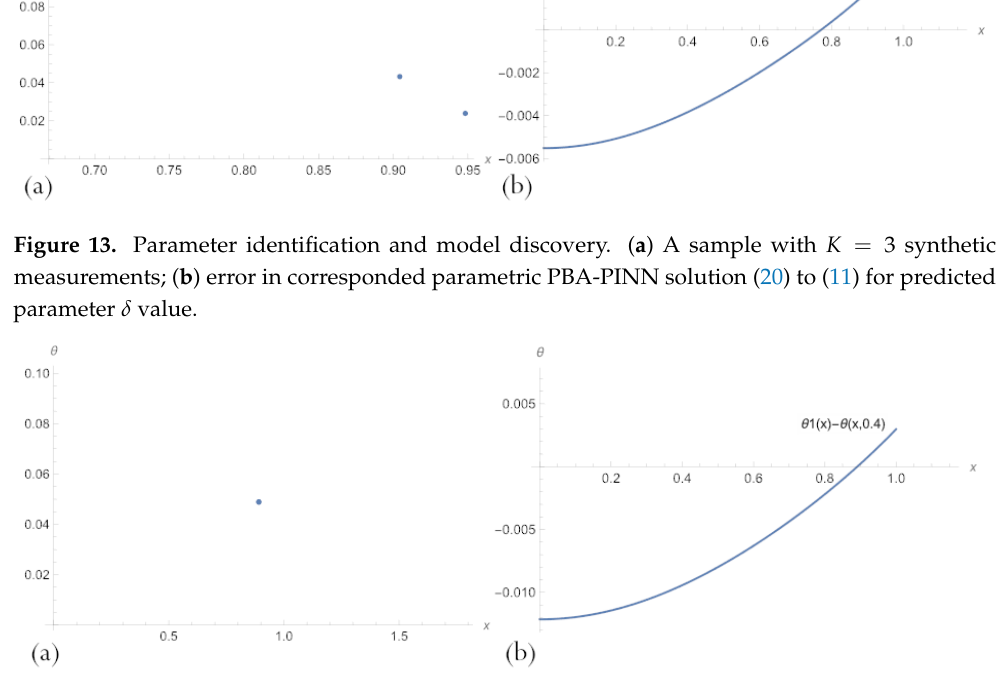
Figure 14. Parameter identification and model discovery. ( a ) A sample with K = 1 synthetic measurement; ( b ) error in corresponded parametric PBA-PINN solution (20) to (11) for predicted parameter δ